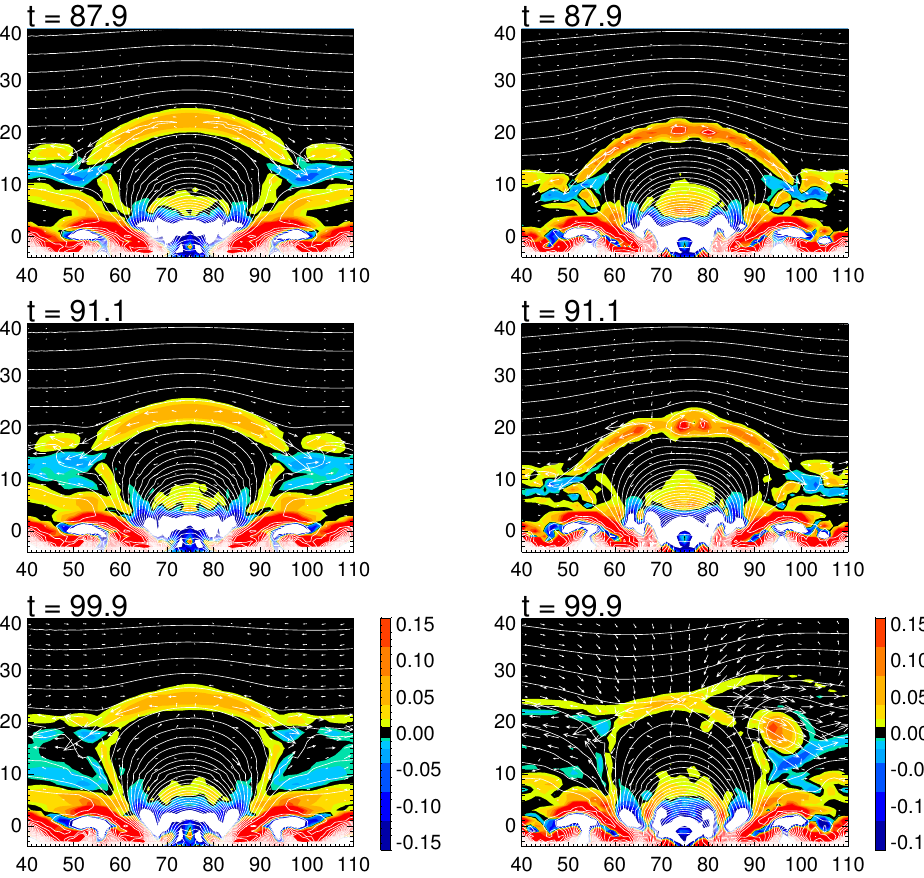
Figure 45: Temporal evolution of current density (color) and magnetic field lines of 2D simulation of emerging flux with uniform (left) and anomalous (right) resistivity models. Image adapted from Yokoyama and Shibata (1994), courtesy of T.